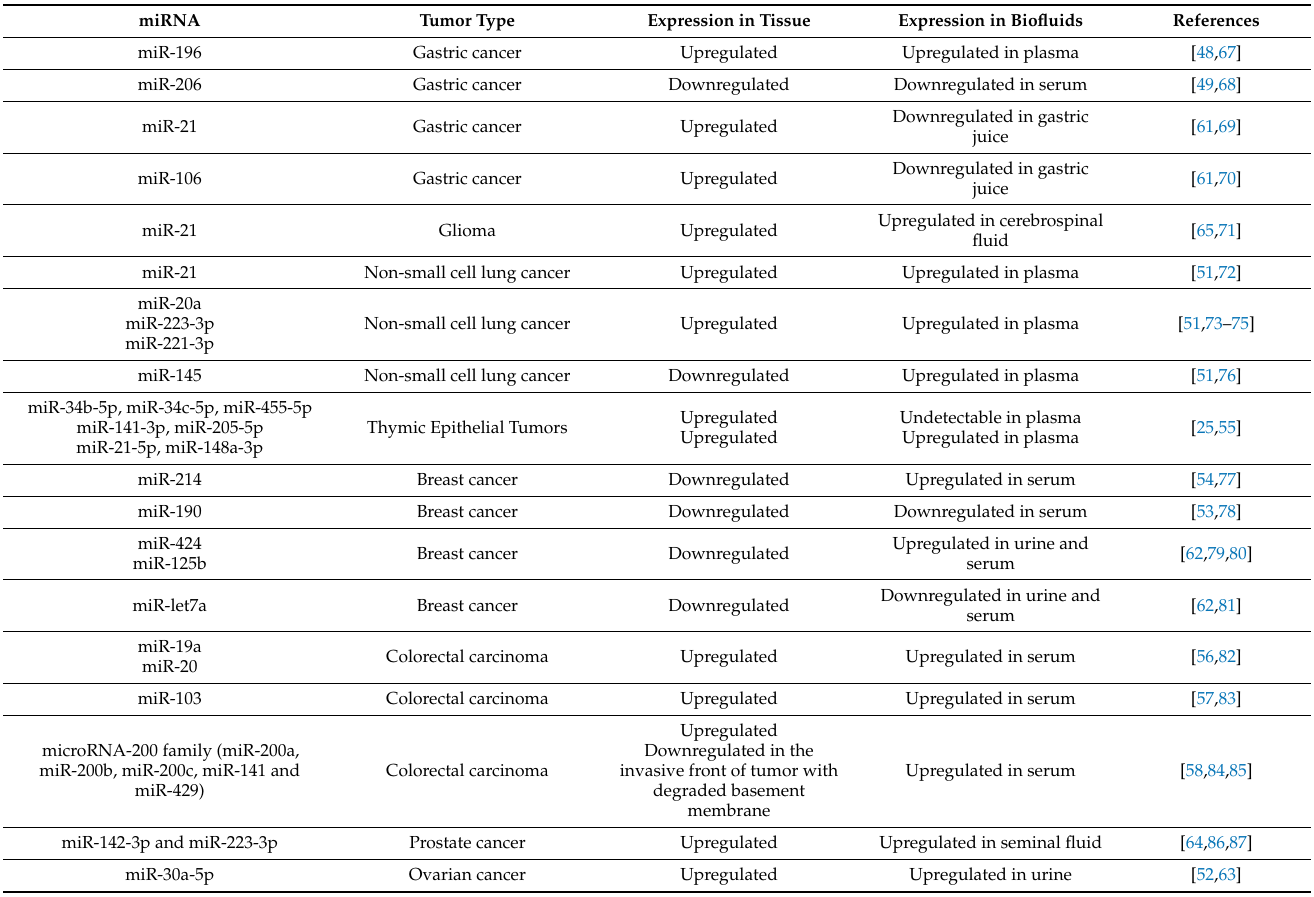
Table 1. Correlation of miRNA levels in liquid biopsies and in matched tissue